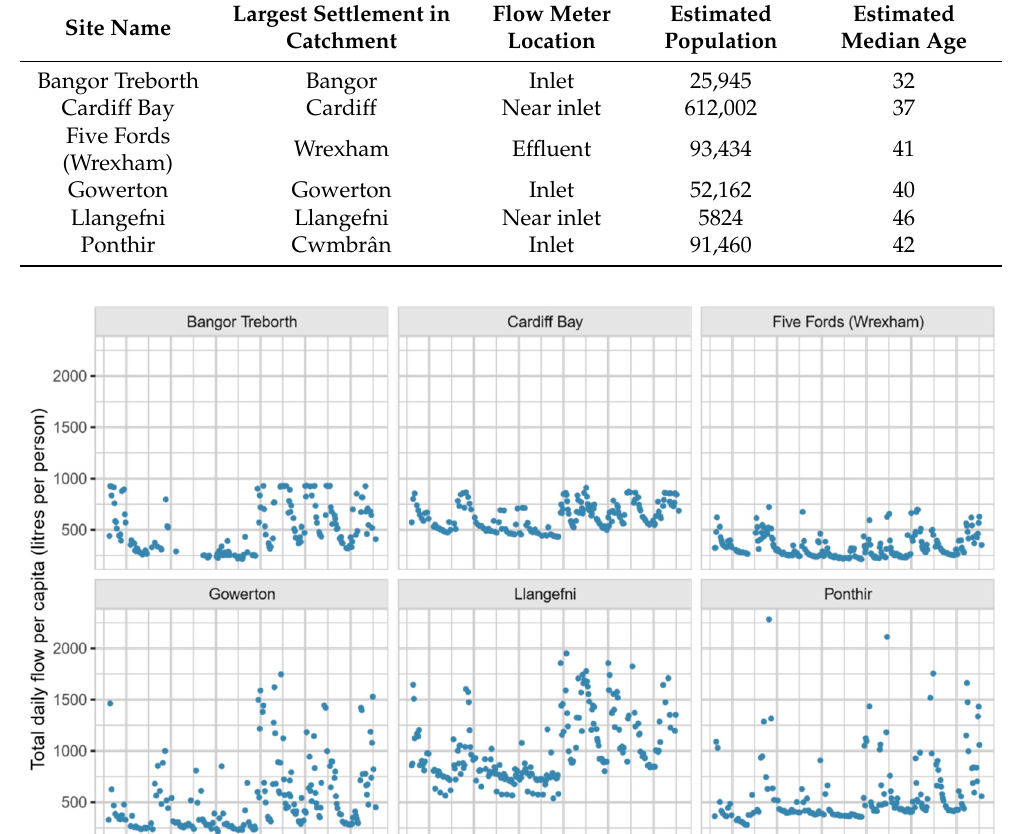
Table 1. Characteristics of the representative sites under surveillance, with data from the Office for National Statistics (ONS), which provides estimates for the mid-2020 population and age of every Lower Layer Super Output Area (LSOA) in England and Wales.